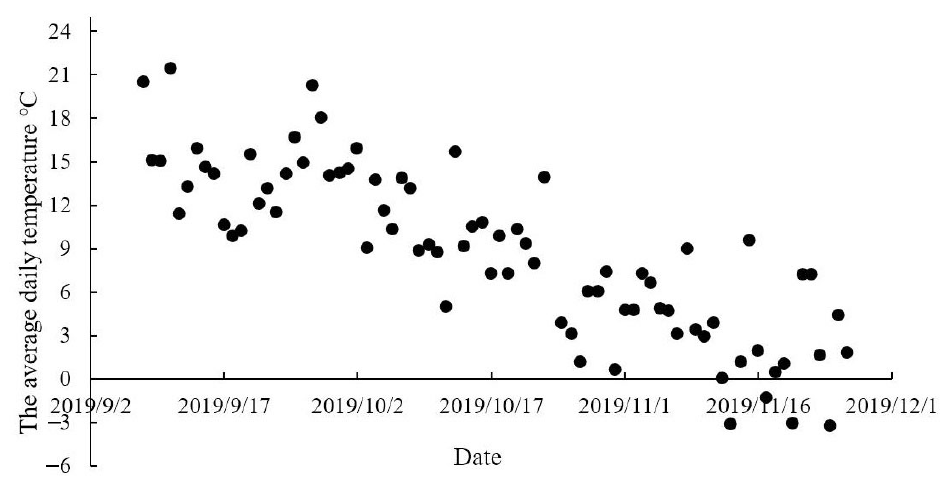
Figure 1. The average daily air temperature throughout the experimental period.